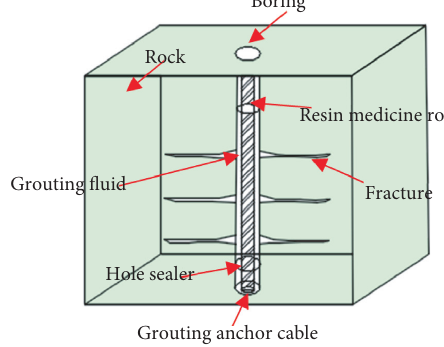
Figure 22: Grouting